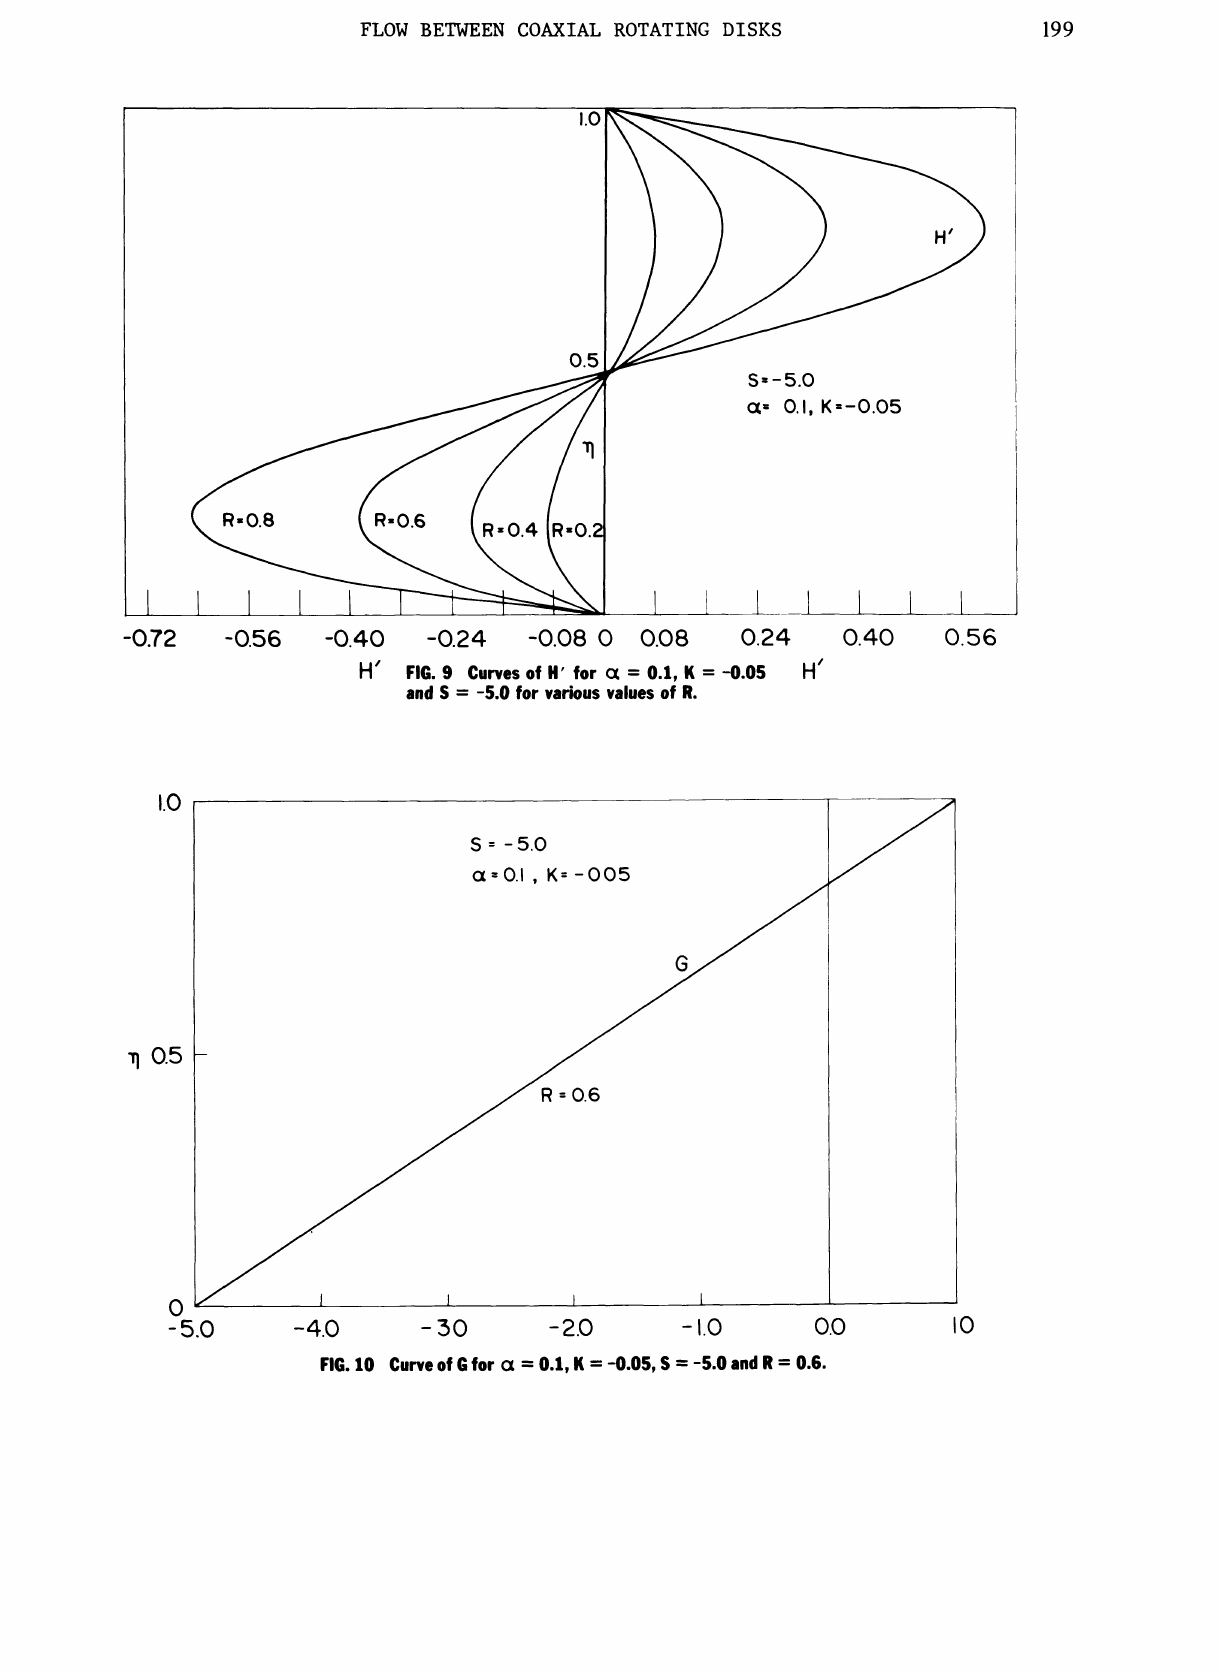
FIG. 9 Curves of H’ for (x